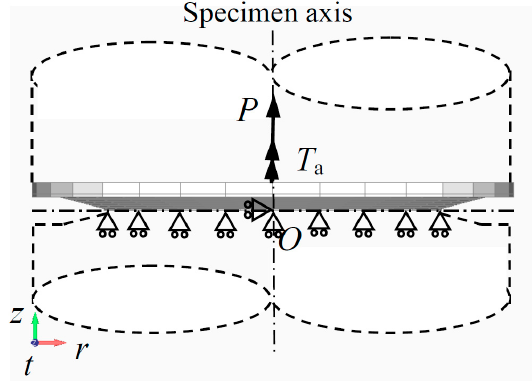
Figure 16. Mesh used for the analyses, and applied loads and boundary conditions.